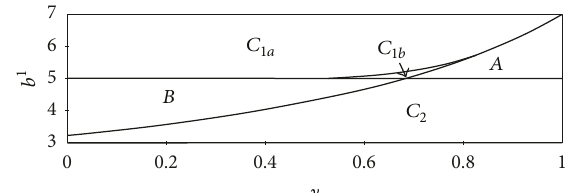
most one positive equilibrium 𝐸 ∗ 3 = (𝑒 ∗ 1 , 𝑒 ∗ 2 ) which can be